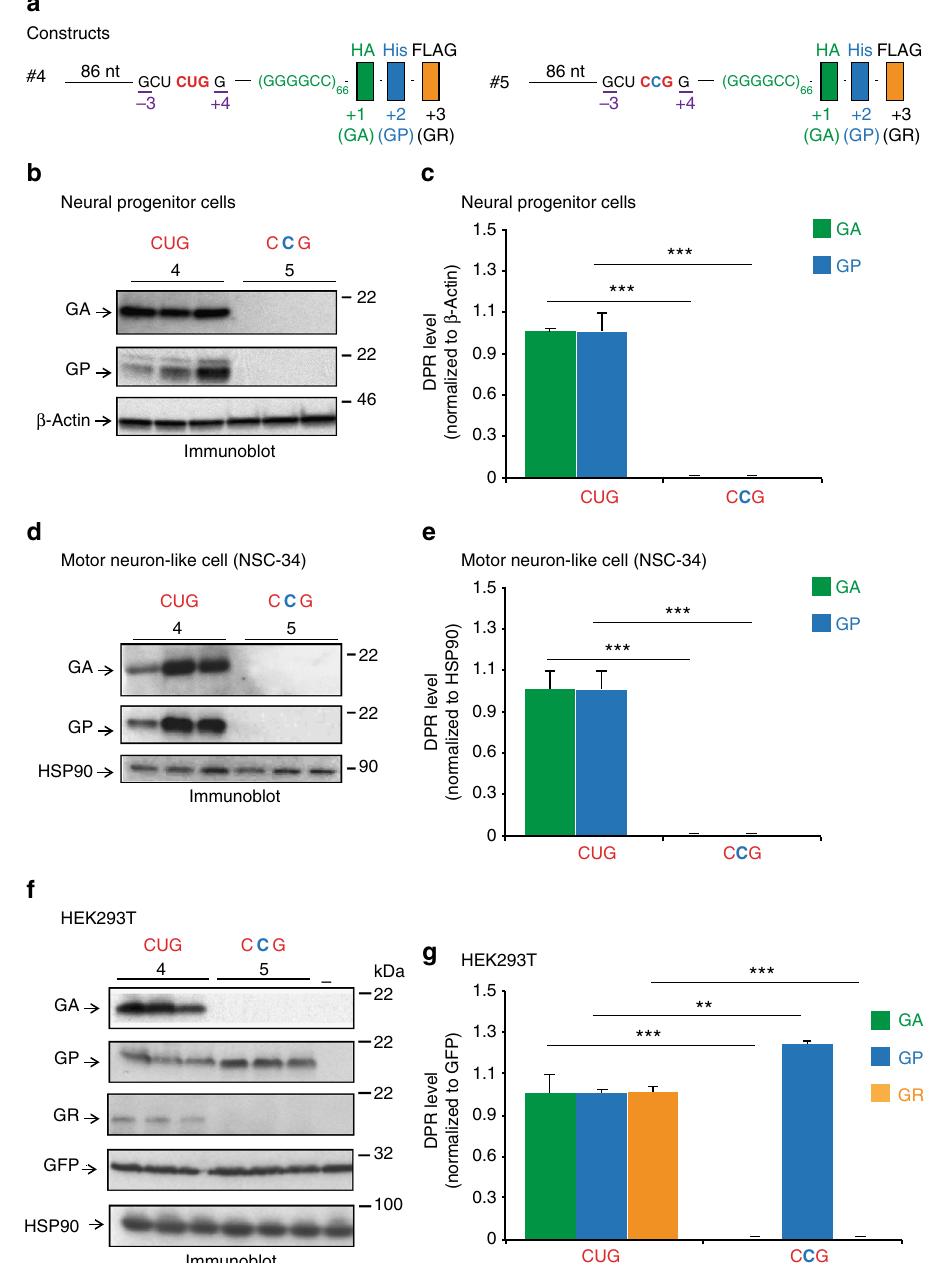
Fig. 4 Poly-GA, poly-GP, and poly-GR RAN translation initiate at the near-cognate CUG start codon in cells. ( a ) Schematic representations of constructs #4 and #5 containing the near cognate start codon CUG or mutant CCG upstream of (G 4 C 2 ) 66 repeats. These constructs are driven by a CMV early enhancer/chicken β actin (CAG) promoter. Human neural progenitor cells ( b – c ), mouse motor neuron like cells (NSC-34) ( d – e ) and human HEK293T cells ( f – g ) were co-transfected with the constructs #4 or #5 along with a GFP plasmid reporter. GFP, Hsp90 or β -Actin proteins were analyzed by immunoblot to control for the transfection ef fi ciency and protein loading. Poly-GA, poly-GP, and poly-GR proteins were identi fi ed by immunoblot using antibodies raised against poly-GA, poly-GP, and poly-GR. Levels of the different DPR proteins were quanti fi ed and normalized to GFP, HSP90 or β -Actin. Error bars indicate SEM of three independent transfections. Student ’ s t - test, ** and *** indicate p < 0.01 and p < 0.001, C9ORF72 ASO (RNA-ASO1) was complementary to a sequence nuclear enzyme RNase H, reducing the level of RNA foci and that overlaps the near-cognate CUG codon, and two ASOs (RNA- DPR proteins in a C9ORF72 transgenic mouse model and patient fi broblasts 7,52 . To determine whether RNA ASOs targeting the 5 ′ ASO2, RNA-ASO3) were chosen to cover sequences located at 41 fl anking G and 82 nucleotides distal from the repeats, respectively (Fig. 6f). 4 C 2 sequence can block the scanning of ribosomes and inhibit RAN translation without inducing RNAse-H-dependent Corresponding RNA sense oligonucleotides (RNA-SOs) were degradation, we generated ASOs selectively targeting the region used as controls (RNA-SO1, RNA-SO2, and RNA-SO3, Fig. 6f). upstream of the repeats and tested their potency in inhibiting All three RNA-ASOs induced a dose-dependent reduction of G 4 C 2 RAN translation in RRL system (Fig. 6f – h). One RNA DPR proteins produced from the capped G 4 C 2 66 repeats RNAs